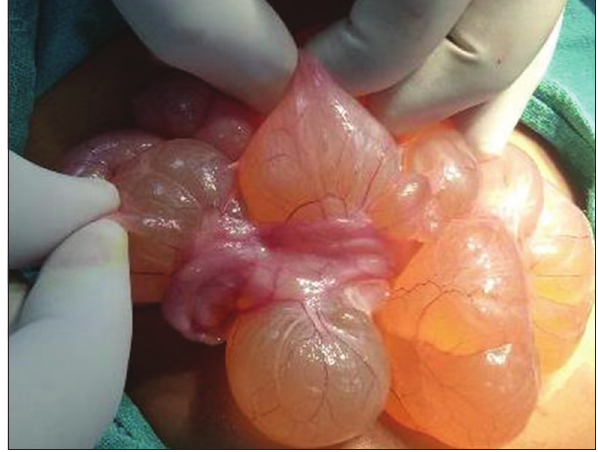
Figure 1: Mesenteric